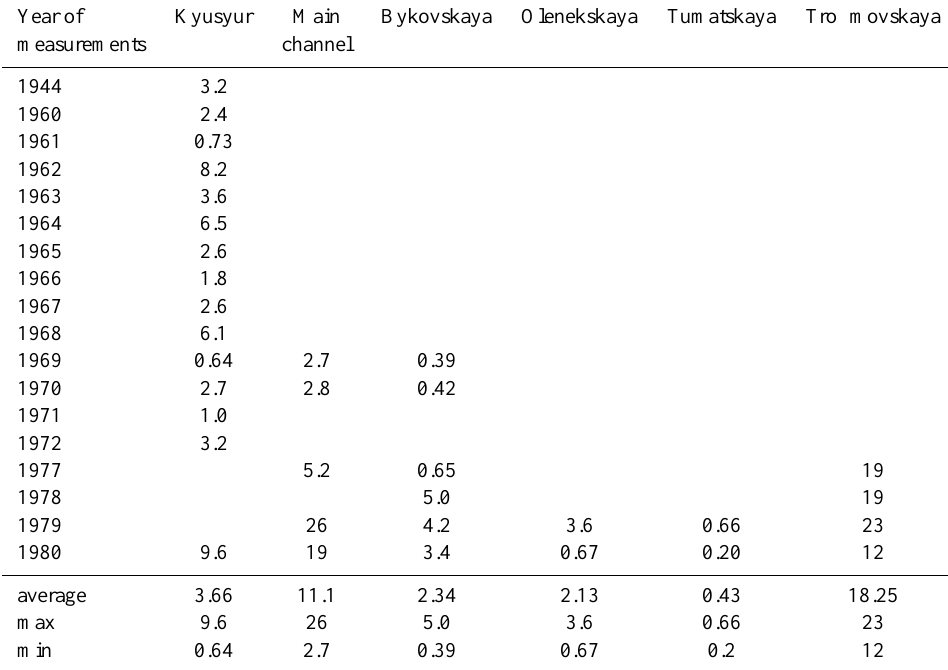
Table 6. Average monthly (for February) sediment discharges (kgL − 1 ) during all periods of long-term observations on the standard hydrom- eteorological cross-sections of Roshydromet on the branch. Year of Kyusyur Main Bykovskaya Olenekskaya Tumatskaya Trofimovskaya measurements channel 1944 3.2 1960 2.4 1961